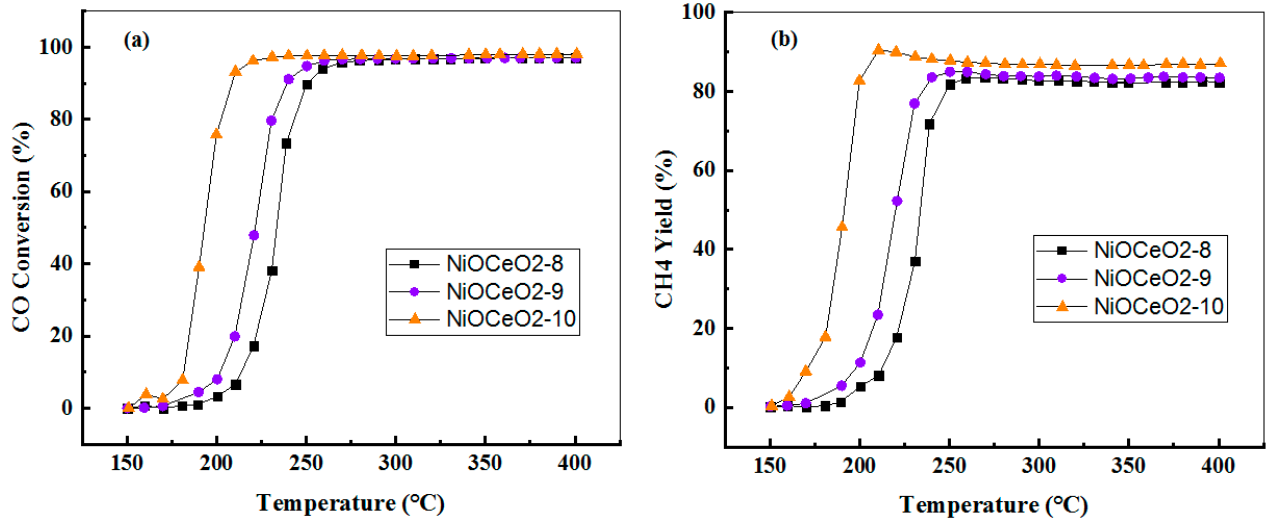
Figure 6. Catalytic performance of NiOCeO 2 in CO methanation as a function of temperature: ( a ) CO conversion and ( b ) CH 4 yield.